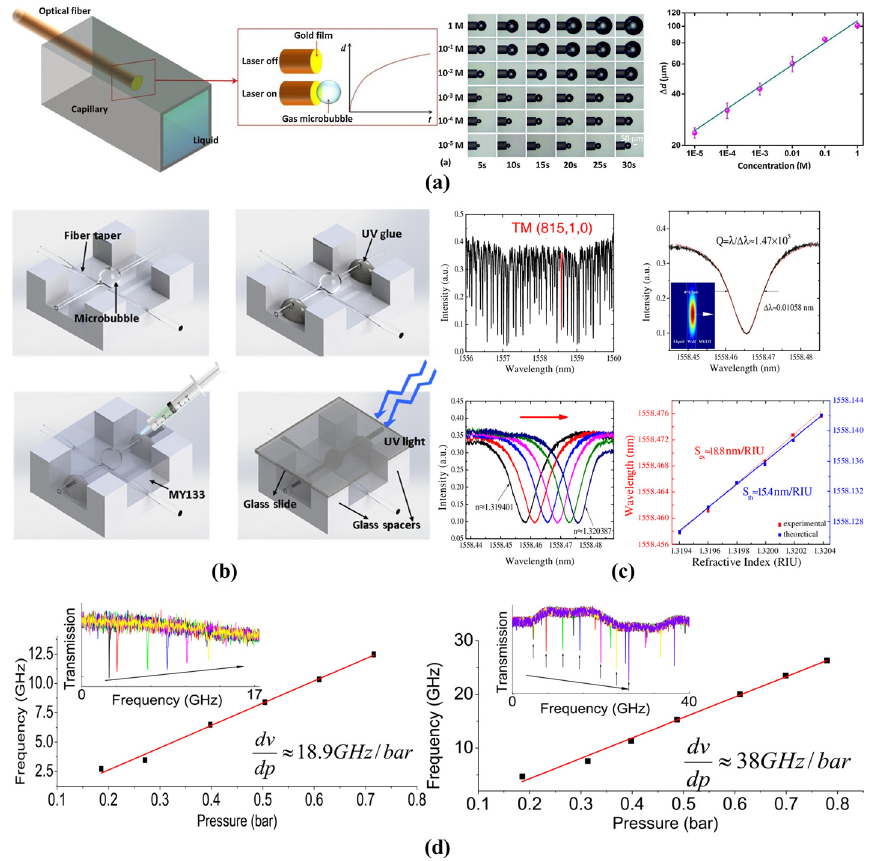
Figure 9. Liquid concentration and pressure sensing with the microbubble resonators: ( a ) a lab-on- fiber microbubble for liquid-concentration sensing (reprinted with permission from [107], © Elsevier); ( b , c ) a packaged microbubble for the liquid RI sensing (reprinted with permission from [89], © Optica, formerly the Optical Society of America); ( d ) pressure sensing with the microbubble resonators (reprinted with permission from [106], © Optica, formerly the Optical Society of America).